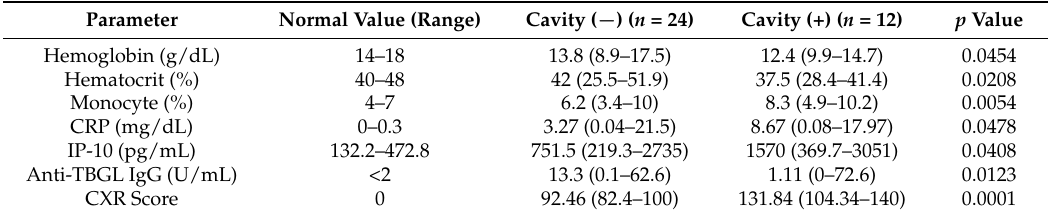
Table 5. Comparison of laboratory findings between TB patients with and without cavity lung formation.